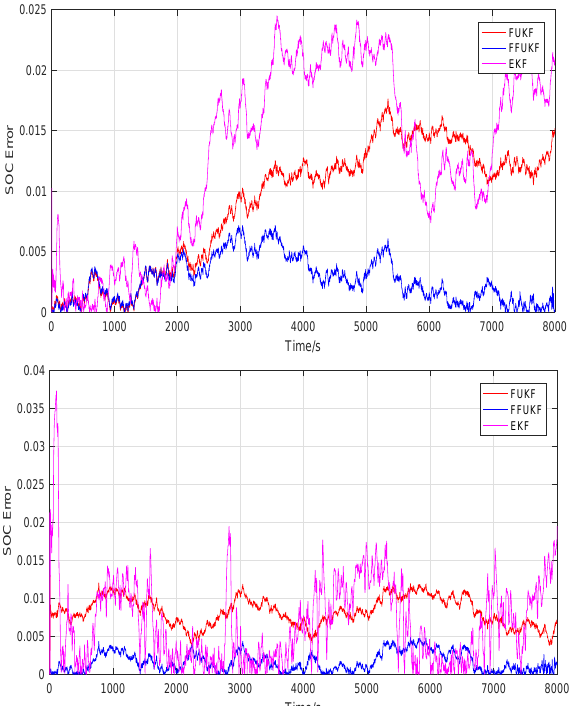
Figure 13. The SOC estimation error curves under BJDST and FUDS at 0 ◦ C. Table 4. The RMSE under BJDST and FUDS at 0 ◦ C. RMSE EKF FUKF FFUKF FUDS 0.88% 0.85% 0.20% BJDST 1.49% 1.04%